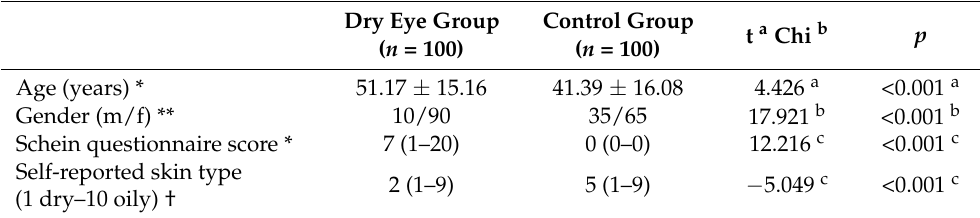
Table 1. Baseline characteristics and skin type of subjects included in the